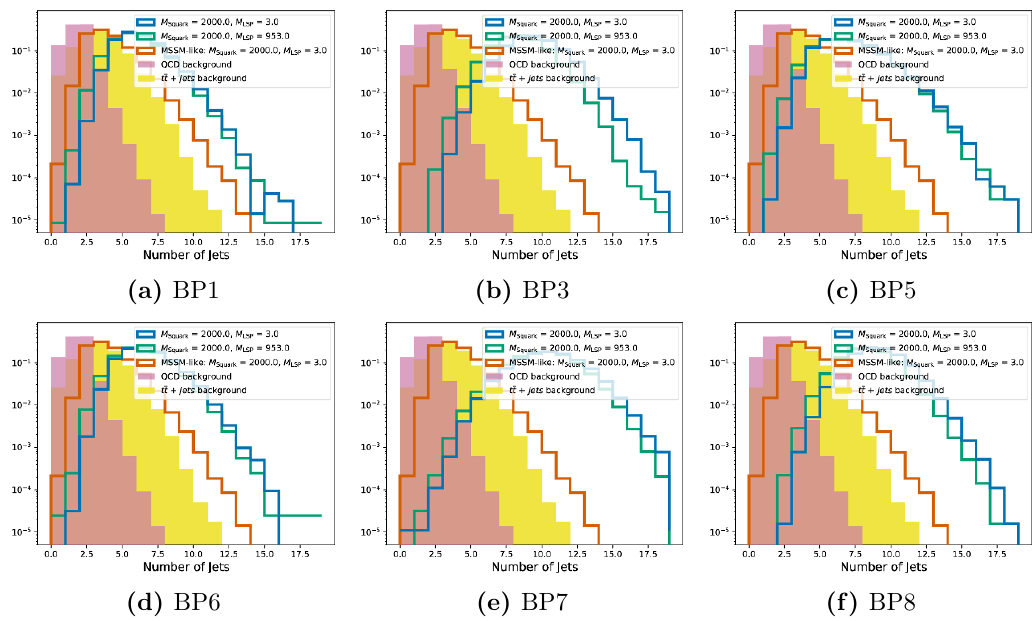
Figure 9. Number of hadronic jets for low and mid-range M LSP near the observed limit in the BP1-type scan, compared with QCD and t (cid:22) t background processes and an MSSM-like scenario with a light LSP.